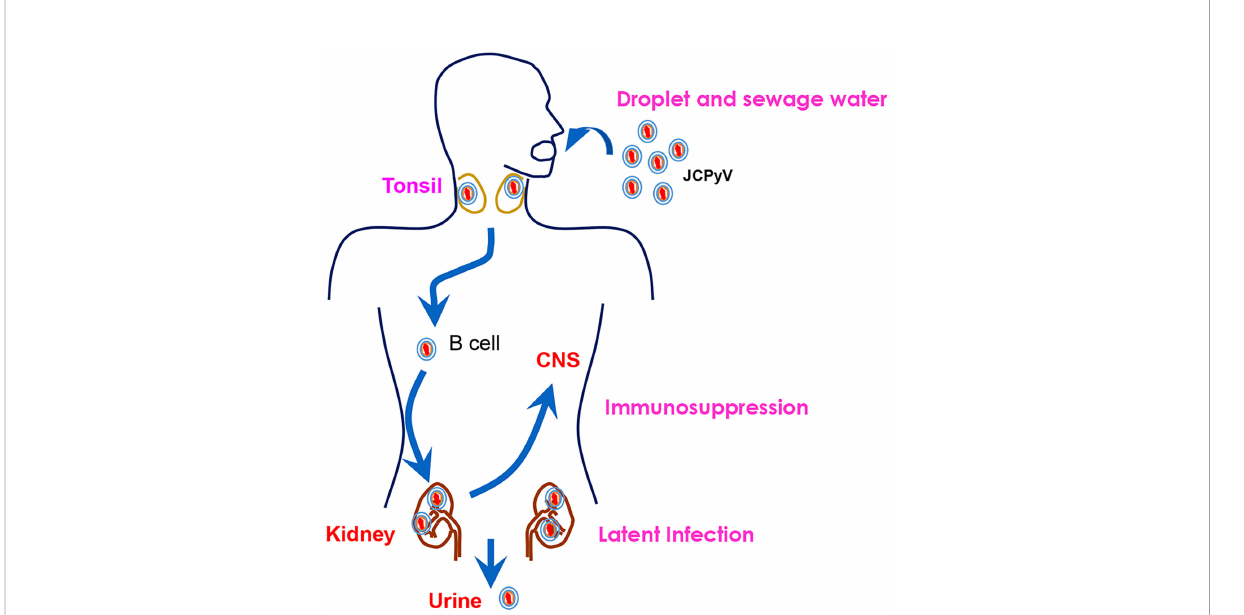
FIGURE 3 The natural history of JCPyV. JCPyV enters the human body through the intake of raw sewage or inhalation of air droplets. It is transported to the kidneys via B cells. It persists quiescently in the tonsil and renal tissues during latency. Upon immunosuppression, JCPyV enters the central nervous system (CNS) and undergoes lytic proliferation, resulting in the demyelinating brain disease, progressive multifocal leukoencephalopathy (PML). It can be excreted from the human body through the